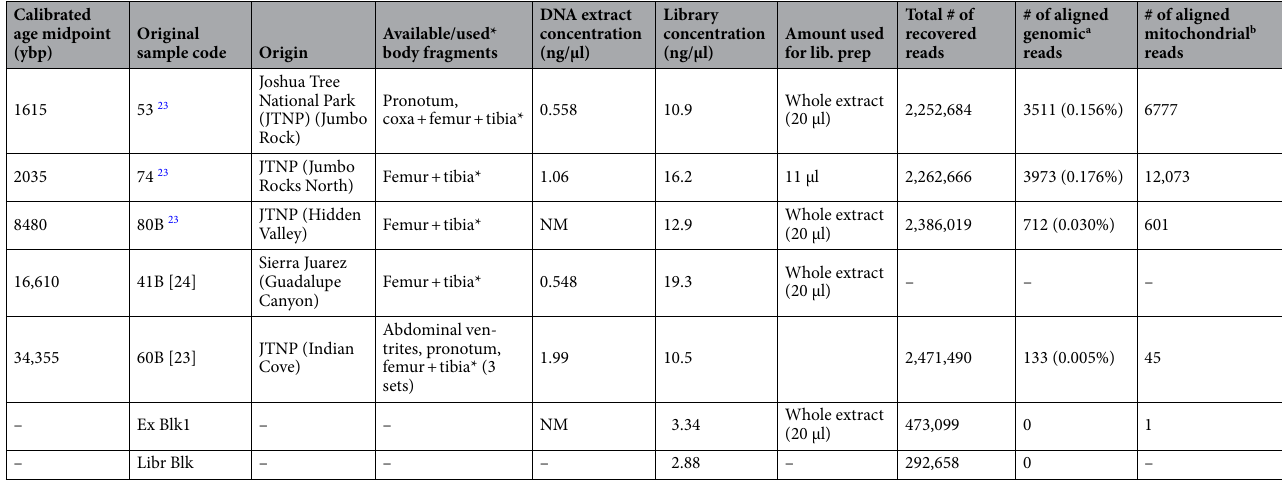
Table 1. Summary of ancient samples reported in this study. *Body part used for extraction; + intact body parts; NM not measurable; Ex and Libr Blk extraction and library blanks; a Endogenous genomic DNA content measured as the total number of recovered reads mapped to the Tribolium castaneum genome; b Number of reads mapped to the reference mitogenome of Philolithus